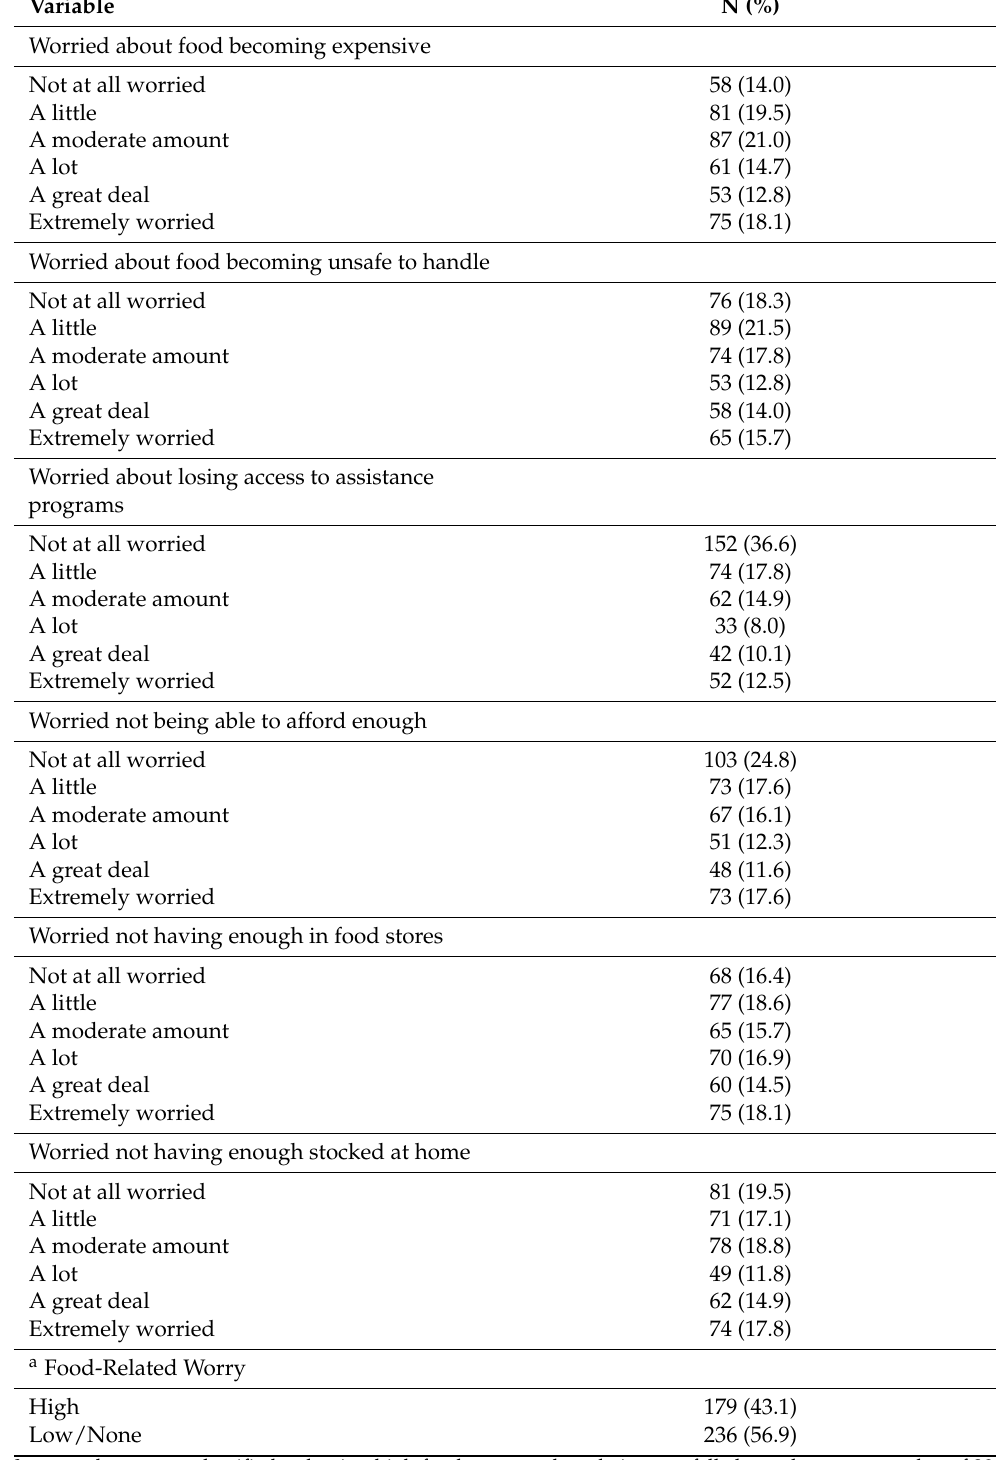
Table 2. Food-related worry among respondents during COVID-19 in New York, United